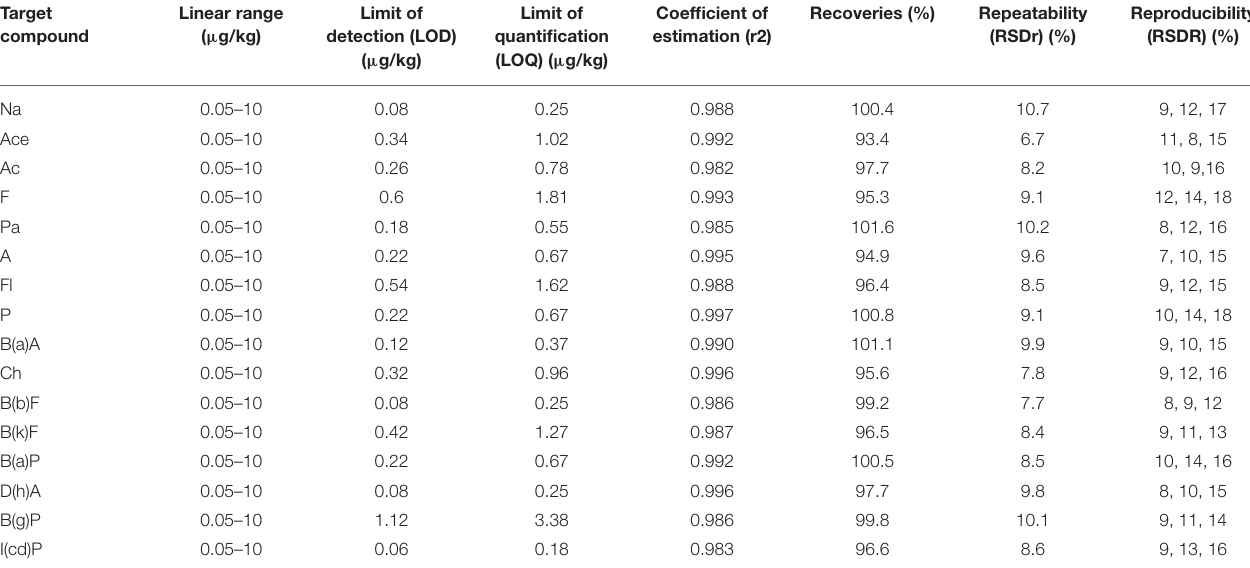
TABLE 3 | Linear range, LOD, LOQ, r 2 , recovery, RSDr ( n = 6), and RSDR ( n = 6) of developed method. Target compound